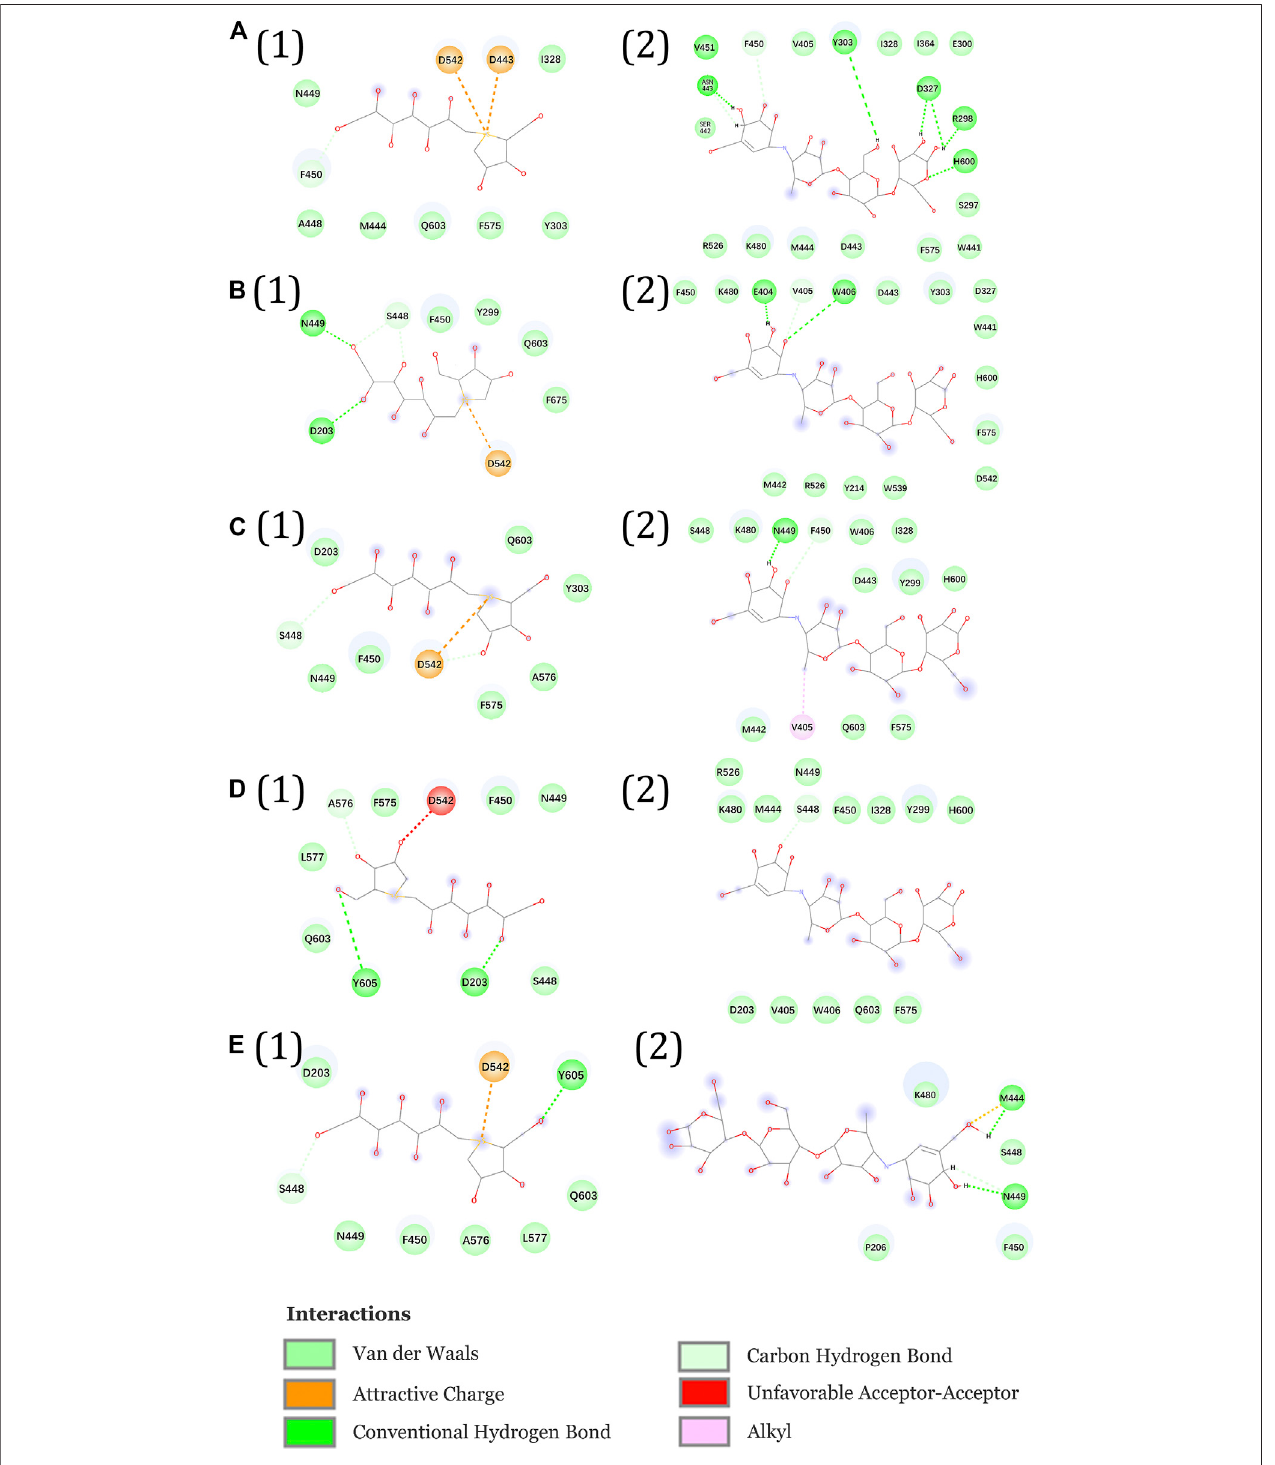
FIGURE 11 | Interactions during ASMD simulations between DSK (1) or acarbose (2) with NtMGAM. (A) The initial state of the two systems before the ASMD simulations. Reaction coordinates reached (B) 8.44 Å, (C) 9.58 Å, (D) 10.96 Å, and (E) 12.72 Å.